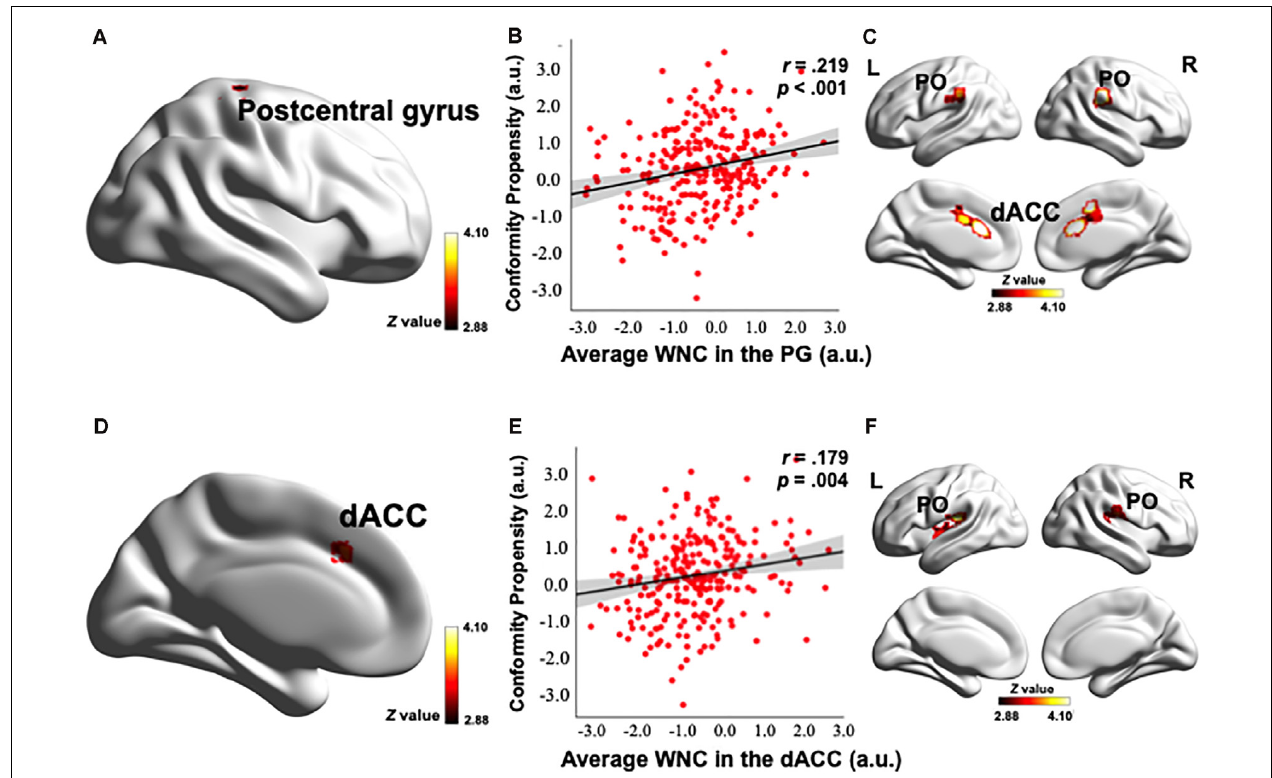
FIGURE 3 | Correlation between the PN WNC and conformity. The PN WNC in the postcentral gyrus (121 voxels, voxel-level p < 0.002, cluster-level p < 0.05, corrected) and dACC (47 voxels, voxel-level p < 0.002, cluster-level p < 0.05, corrected) was positively correlated with conformity (A,D) . The scatter plots are shown just for illustration and visualization of the partial correlation (controlling for gender and head motion) between the PN WNC in the postcentral gyrus (PG), dACC, and conformity (B,E) . Correlation between the seed-based FC and conformity is shown in panels (C,F) . (C) The FC between the postcentral gyrus seed and the clusters in the dACC and bilateral parietal operculum (PO) was positively correlated with conformity. (F) The FC between the dACC seed and the clusters in the bilateral PO was positively correlated with conformity. To better visualize the location of the significant clusters, the boundary of the clusters are shown with a red contour. L, left; R, right; a.u., arbitrary units. The visualization was provided by BrainNet Viewer